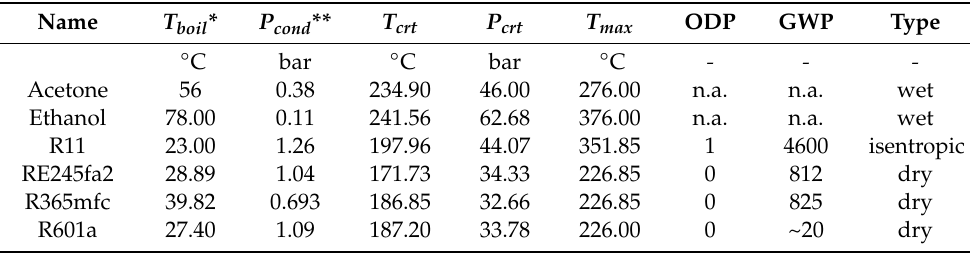
Table 3. The thermodynamic properties and types of the selected working fluid